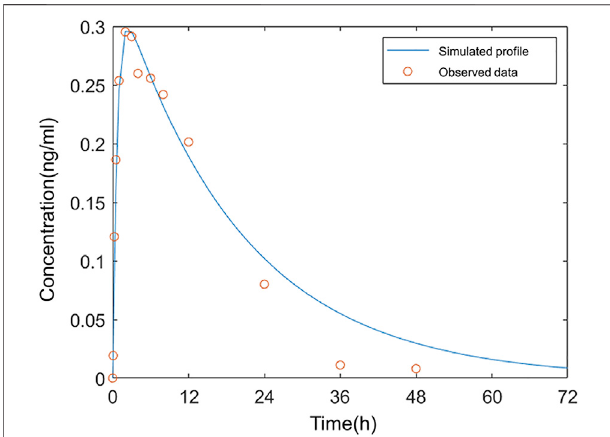
FIGURE 4 | Comparison of the observed concentration – time curve following intranasal administration in Americans to the simulated.